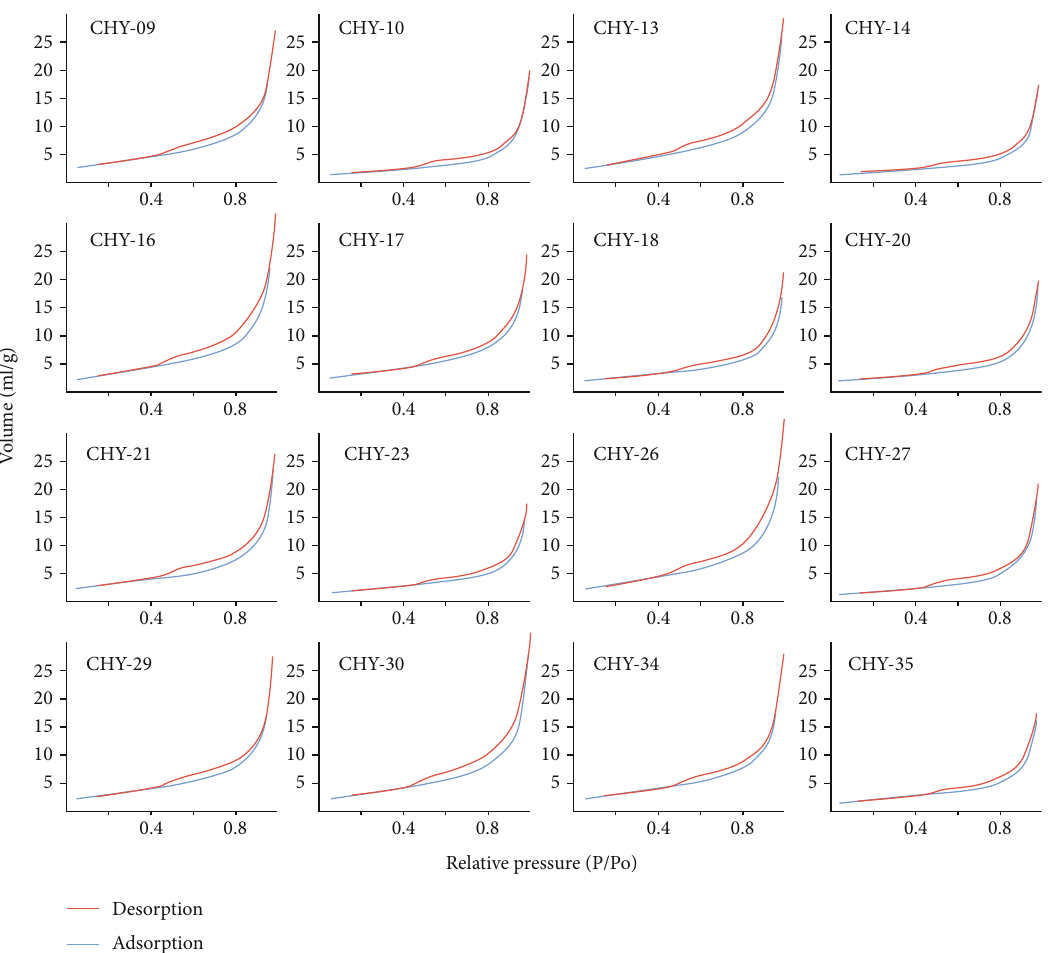
Figure 7: N adsorption-desorption isotherms of shale of the Keluke 2